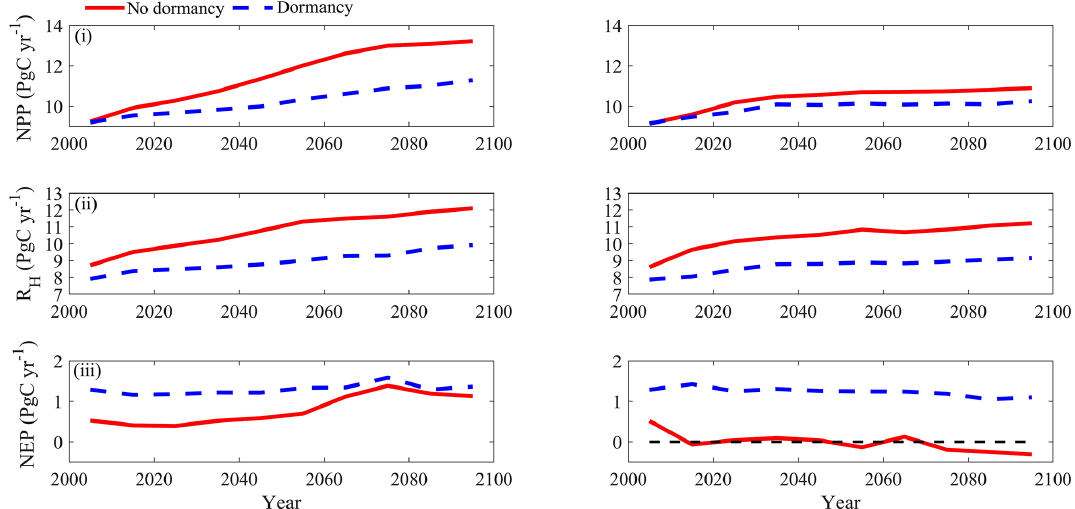
Figure 9. Predicted changes in carbon fluxes: (i) NPP, (ii) R H , and (iii) NEP for all land areas north of 45 ◦ N in response to transient climate change under the RCP8.5 scenario (left panels) and RCP2.6 scenario (right panels) with the dormancy model and MIC-TEM, respectively. The decadal running mean is